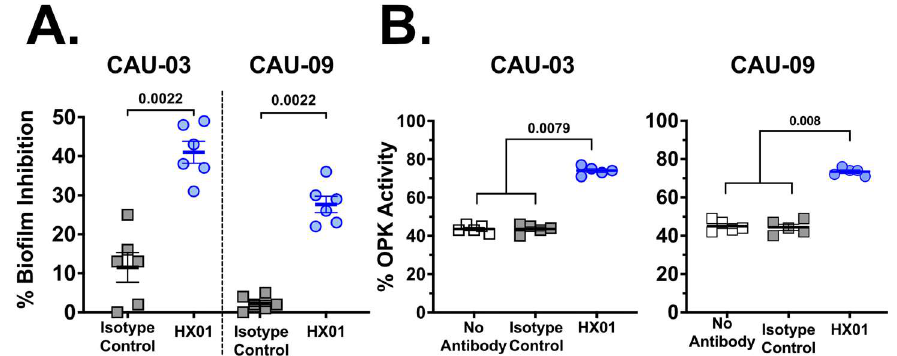
Figure 4. HX01 MAb inhibits C. auris biofilm formation and enhances OPK activity of murine macrophages. ( A ) C. auris (0.1 million cells/well of CAU-03 and CAU-09 isolates) biofilm formation was evaluated in 96-well plates in the presence of HX02 or an isotype-matched control IgG. HX01 significantly reduced C. auris biofilm formation compared to control IgG ( n = 6). Percent biofilm inhibition was determined by comparing wells with C. auris with no antibody added. ( B ) OPK of C. auris (0.1 million cells/well) by murine macrophages (0.25 million cells/well) was evaluated in the presence of HX01 or an isotype-matched control IgG. HX01 significantly enhanced yeast OPK compared to control antibody ( n = 5). Percent killing of C. auris was calculated by formula: {(X − Y)/X} × 100, where X = C. auris CFU in the absence of antibody and macrophages and Y = C. auris CFU with macrophages added in the presence or absence of antibody. Data are representative of two independent experiments. Statistical significance was determined by the Mann–Whitney Test. p values < 0.05 were considered statistically significant.